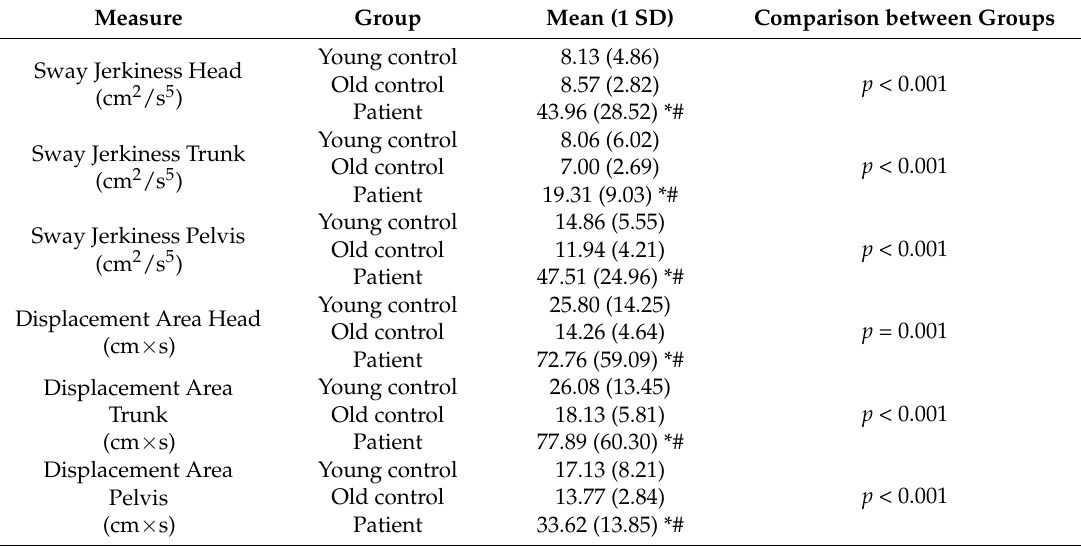
Table 2. Group comparison of postural sway variables with the eyes open